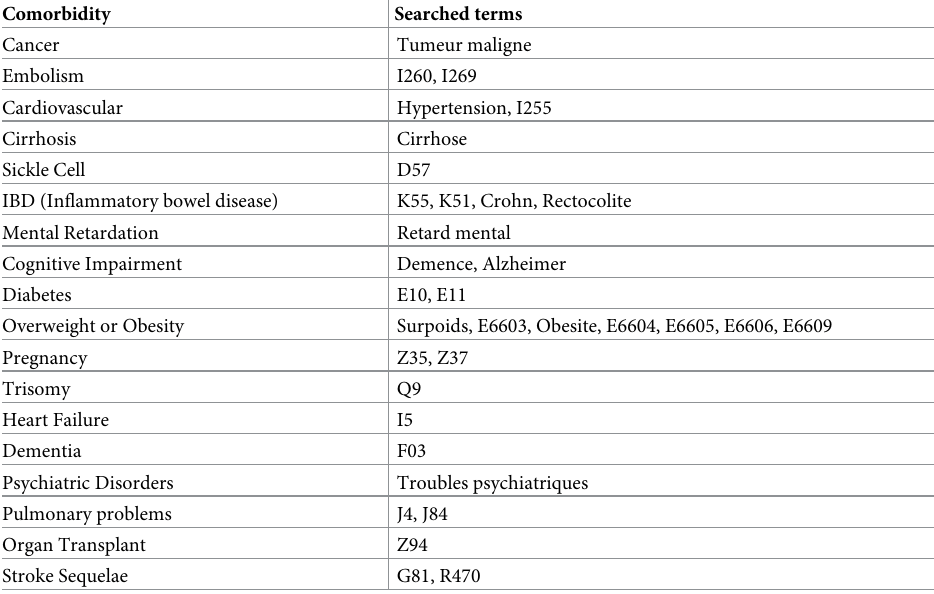
Table 1. Searched terms for binary comorbidity indicator in